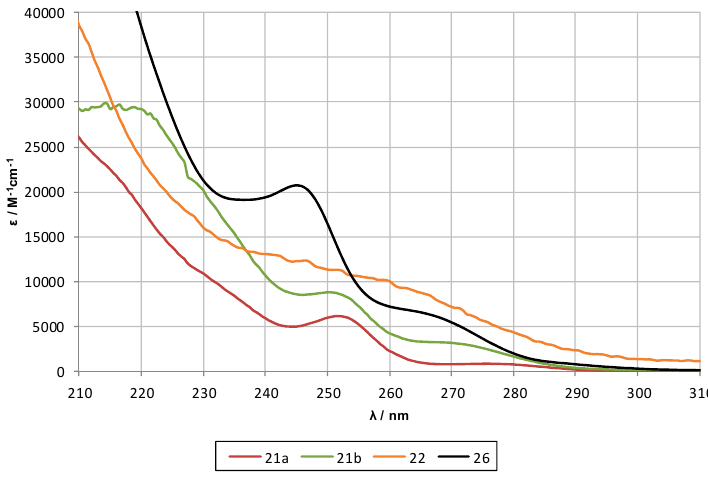
Figure 10. Comparison of the UV spectra of cyclosilanes 21a , 21b , 22 , 23 , 24 , and 26 .